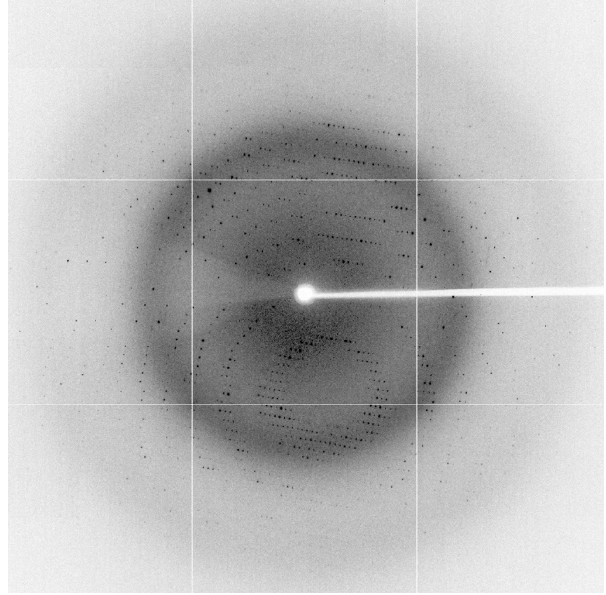
Figure 1. Representative X-ray diffraction image from NTR 2.0 crystal. The edge of the detector corresponds to a resolution of 1.71 Å.